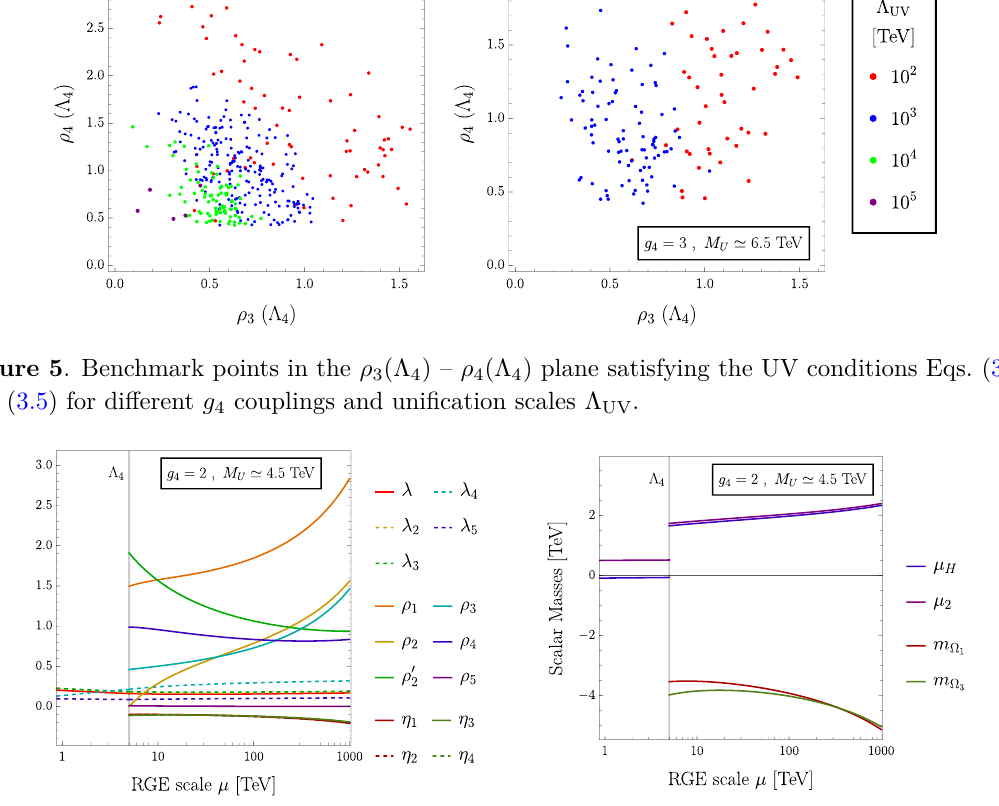
Figure 6 . RG running of the gauge and top Yukawa couplings (left) and couplings of the scalar potential (right) with a benchmark reaching the UV conditions eqs. (3.4) and (3.5). The y-axis, scalar masses, is defined as in figure